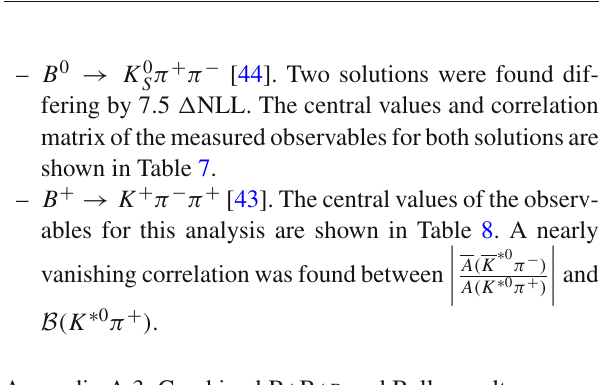
Table 5 Central values and total (statistical and systematic) correlation matrix for observables from the BaBar B + → K 0 π + π 0 B + → K 0 S